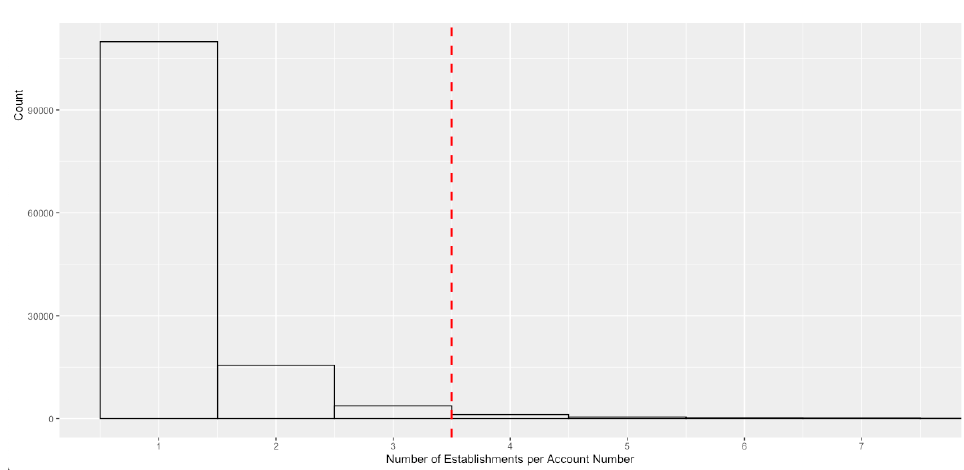
Figure A.1: Histogram showing the distribution of the number of establishments associated with a unique account number. 97.9% of establishments in the dataset are in accounts with fewer than 4 associated